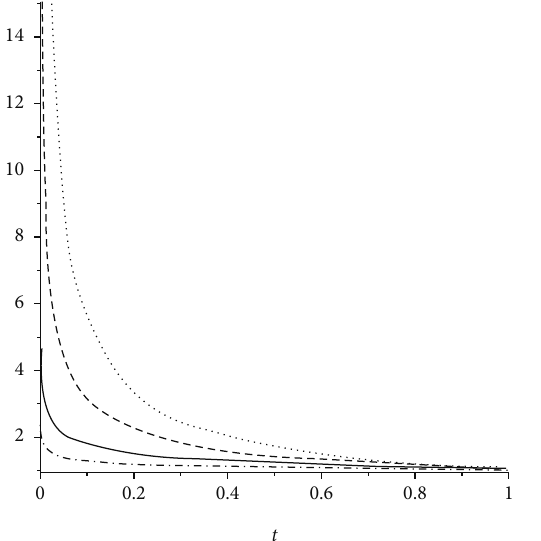
ð x , t Þ for Equation (1) for k 1